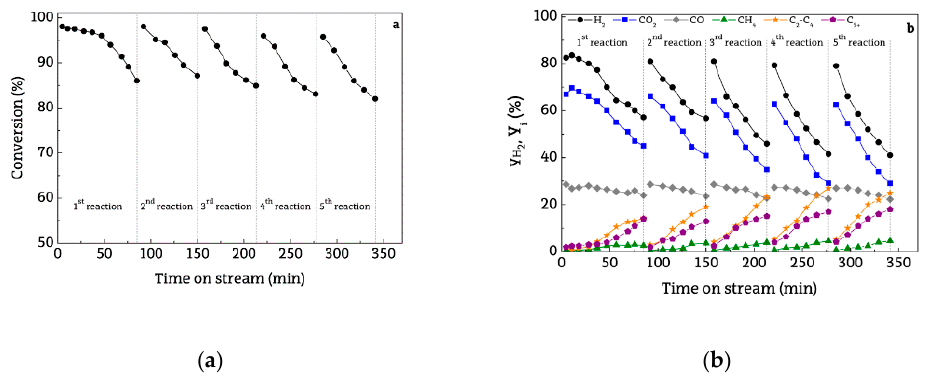
Figure 2. Evolution of high-density polyethylene (HDPE) conversion ( a ) and product yields ( b ) in the successive reaction-regeneration cycles with time on stream.